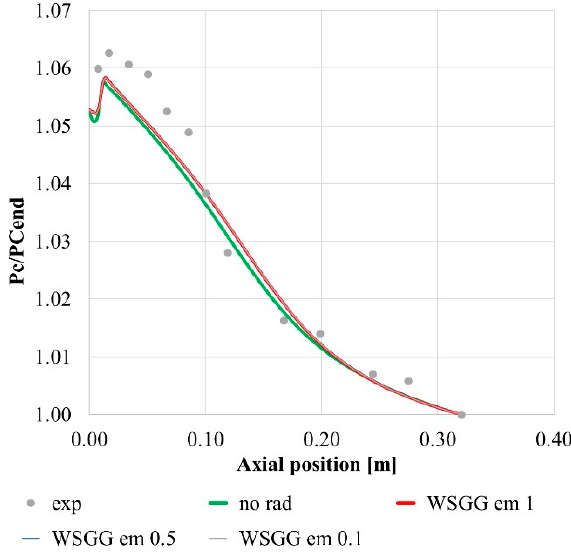
Energies 2020 , 13 , x FOR PEER REVIEW Figure 29. Normalized axial pressure distribution. Figure 29. Normalized axial pressure distribution.